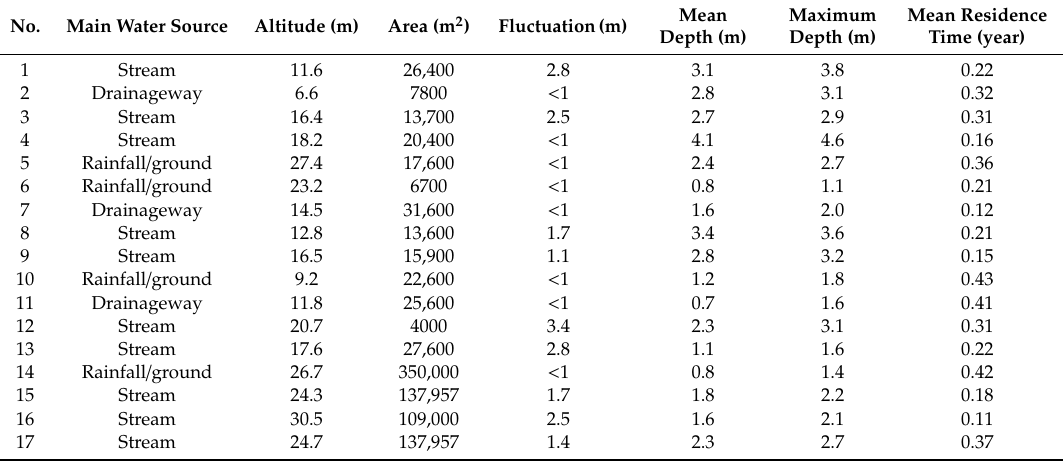
Table 1. Morphometric and limnological description of 17 investigated riverine wetlands. Fluctuation refers to the annual water level fluctuation (values > 1 m are regulated). Rainfall / ground, Rainfall /